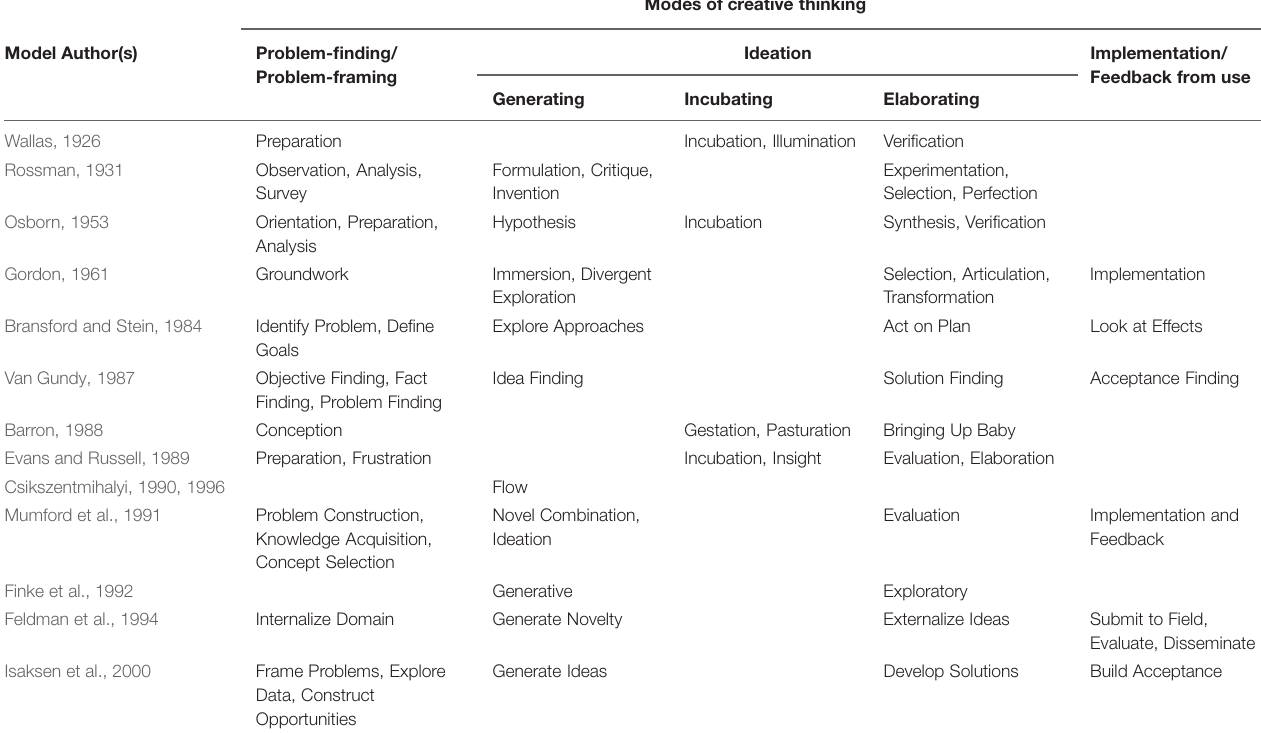
TABLE 1 | Creative stage models